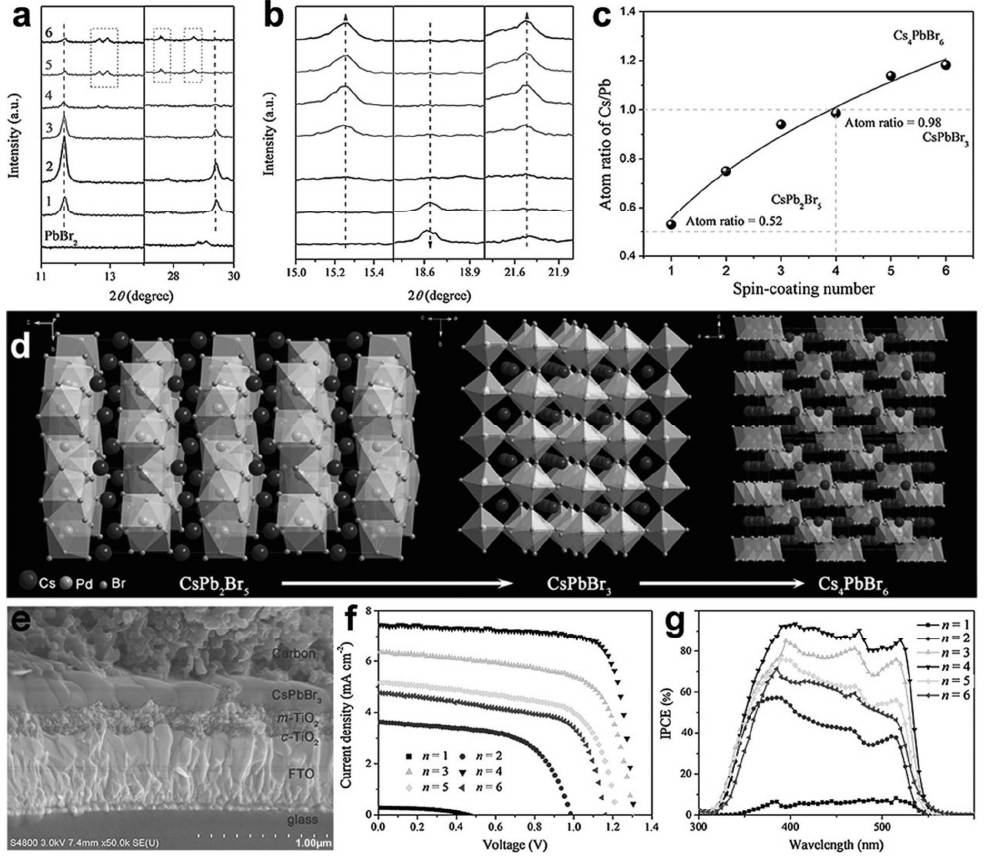
Figure 4. Phase transition of thin films of cesium lead bromide: ( a ) X ‐ ray ‐ diffraction patterns at n = 1 to n = 6 (where “ n ” denotes the number of CsBr layer deposition cycles) in the 2 θ range of 11°– 30.8°; ( b ) X ‐ ray ‐ diffraction patterns at n = 1 to n = 6 in the 2 θ range of 15° to 22.8°; ( c ) Atomic ratio of Cs/Pb at various cycles of deposition; ( d ) Crystalline architecture of the cesium lead bromide perovskites; ( e ) Scanning electron microscope snapshot of the cross ‐ section of cesium lead bromide perovskite solar cell; ( f ) J – V characteristics of the device fabricated at various deposition cycles and reported at a standard solar illumination of AM 1.5 G, ( g ) External quantum efficiency (EQE) of the device. Adapted with permission from [48]. 3. Compositional Engineering of All ‐ Inorganic Perovskites Organic–inorganic hybrid perovskite material ABX 3 is composed of organic cations as A, Pb 2+ or other divalent metal cation as B, and halide, or a mixture of halides, as X. When the organic cations are replaced by inorganic components, such as cesium (Cs + ), it leads to the formation of all ‐ inorganic perovskites. The composition of all ‐ inorganic per ‐ ovskite materials can be engineered under two categories, namely, lead ‐ based and lead ‐ free. These subcategories are discussed in the following subsections. 3.1. Lead ‐ Based All ‐ Inorganic Perovskite Solar Cells The most extensively investigated all ‐ inorganic perovskite material is cubic α‐ CsPbI 3 having a 1.73 eV bandgap, which conforms favorably to the solar spectrum. However, this high temperature ( α ) phase is unstable at ambient temperature, due to which the photo ‐ voltaic performance of CsPbI 3 is gravely hampered. To overcome this problem, various